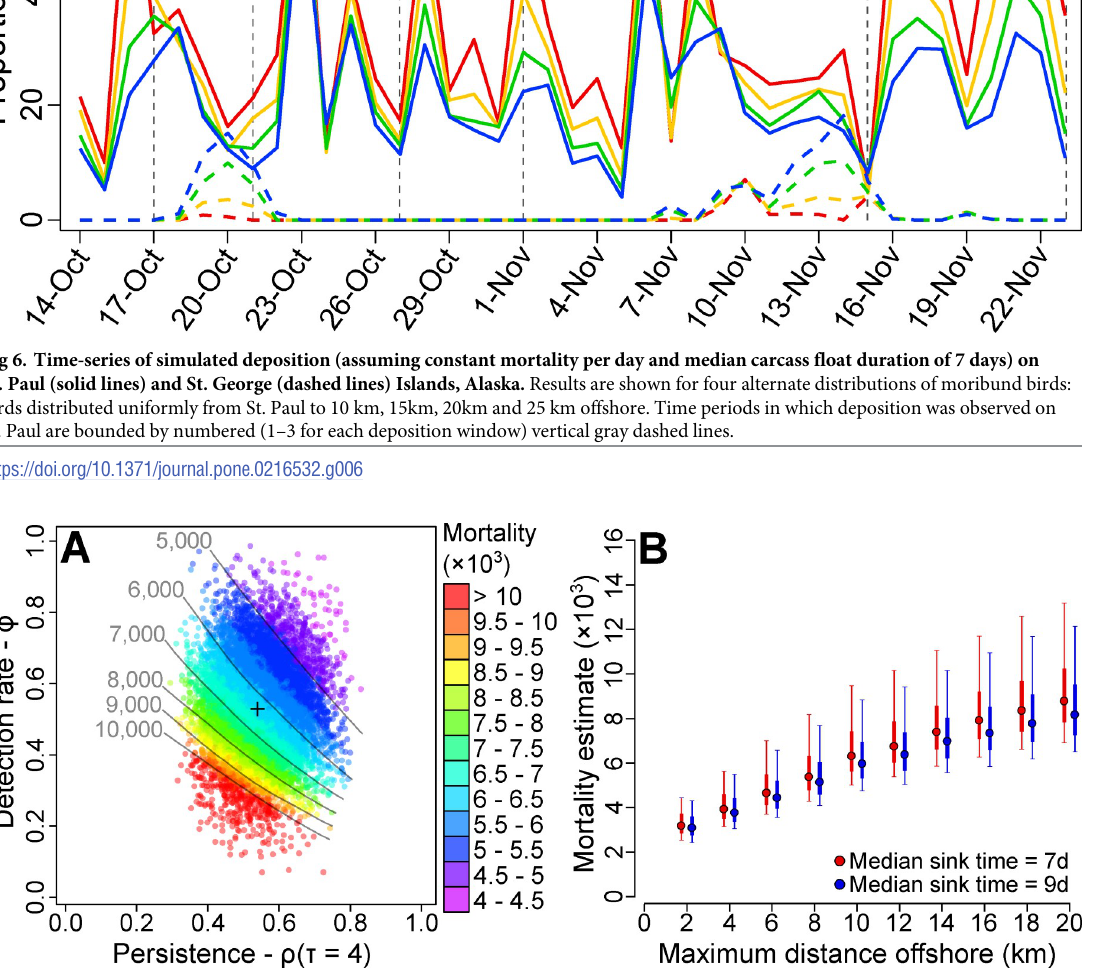
PLOS ONE | https://doi.org/10.1371/journal.pone.0216532 May 29,